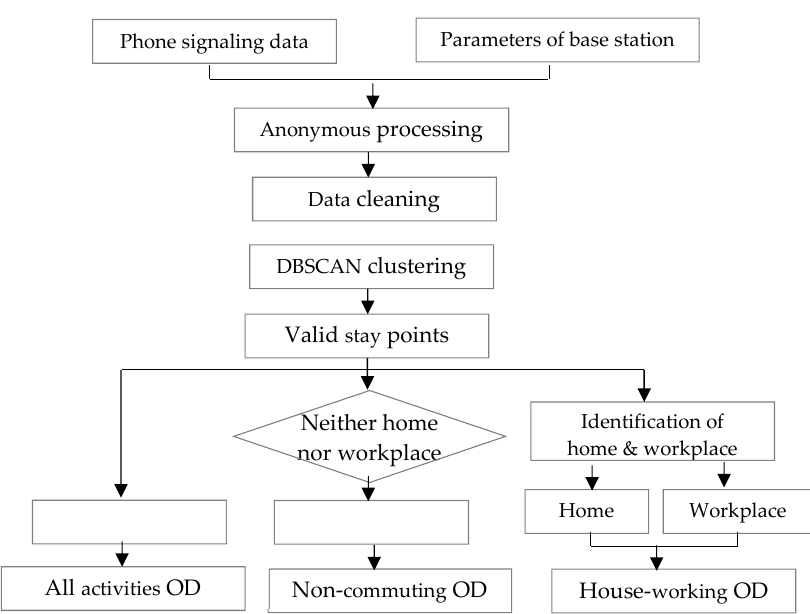
Figure 4. The data processing of Unicom phone signaling data.